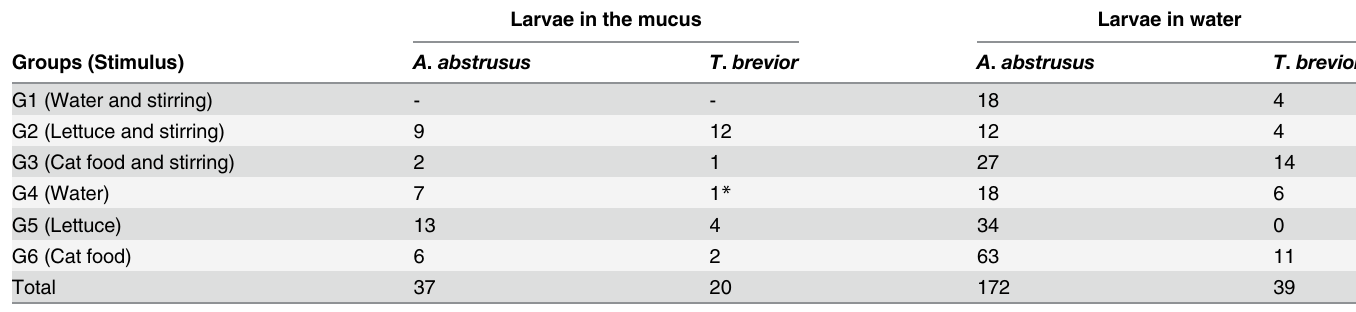
Table 1. Group and total number of Aelurostrongylus abstrusus and Troglostrongylus brevior larvae detected in the mucus of Helix aspersa snails or in the water solution where gastropods had died. Larvae in the mucus Larvae in water Groups (Stimulus) A . abstrusus T . brevior A . abstrusus T . brevior